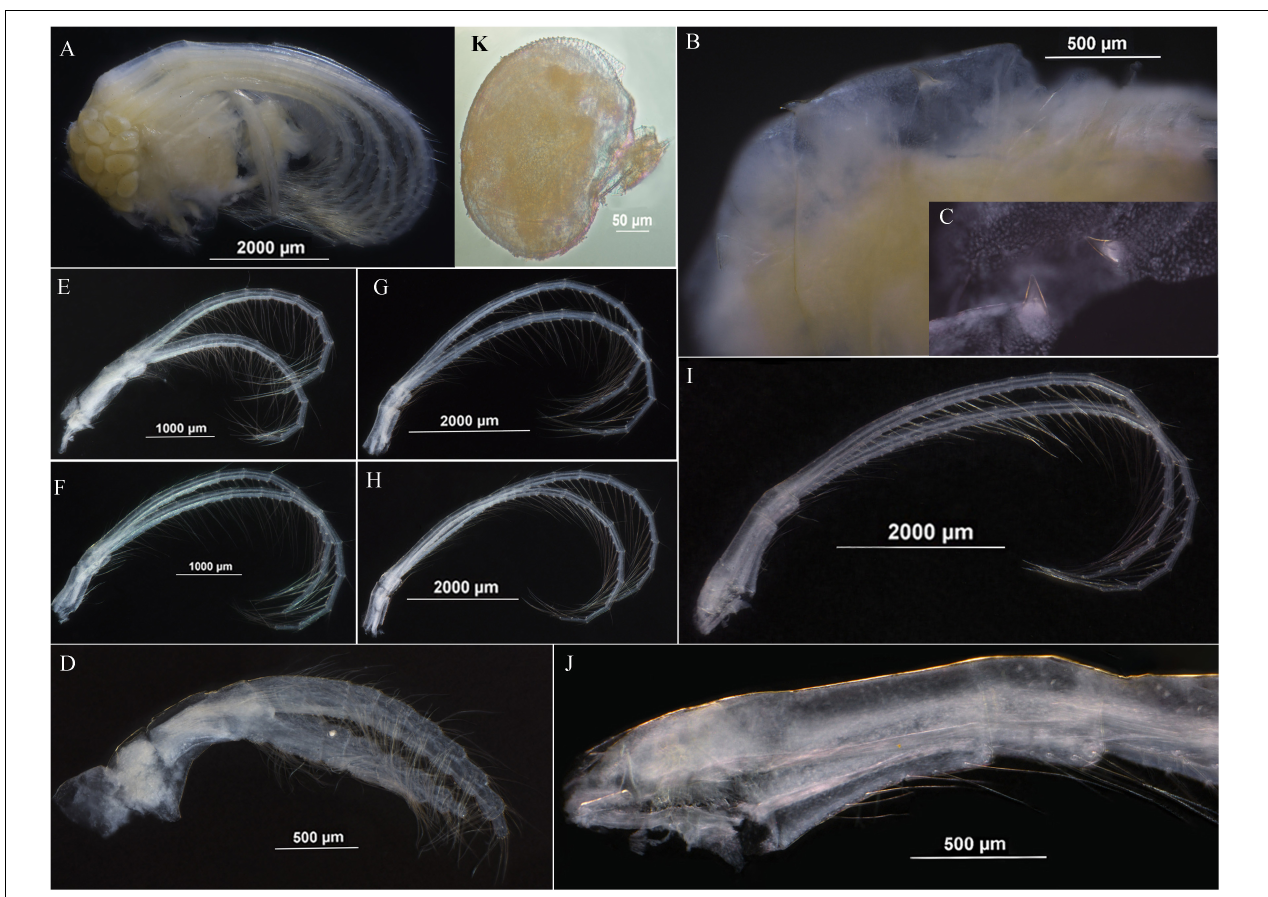
FIGURE 4 | Arcoscalpellum angularum sp. nov. holotype. (A) Soft body. (B,C) Angular processes on dorsum of thorax. (D) Cirrus I. (E) Cirrus II. (F) Cirrus III. (G) Cirrus IV. (H) Cirrus V. (I) Cirrus VI. (J) Basal part of cirrus VI. (K) Dwarf male.